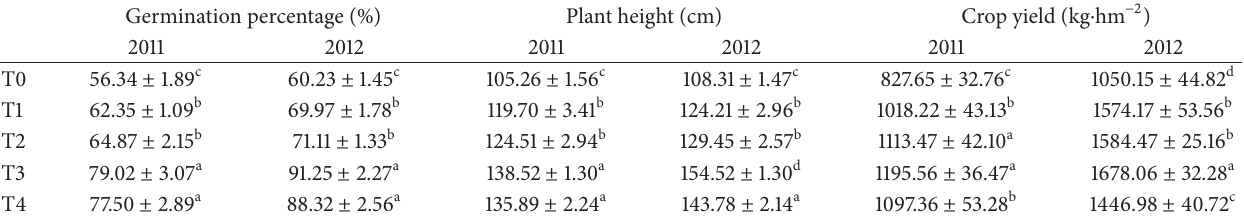
Table 9: Effect of FGDB on germination percentage, plant height, and crop yield during two cropping